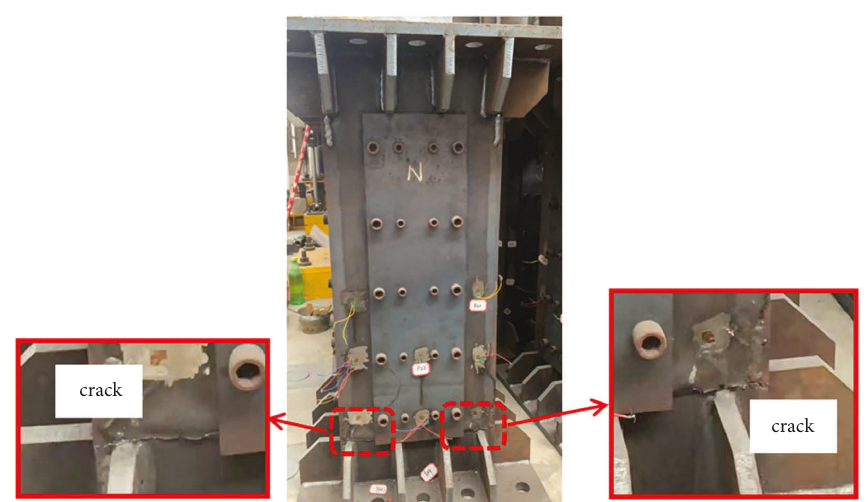
Figure 12: Failure mode of specimen